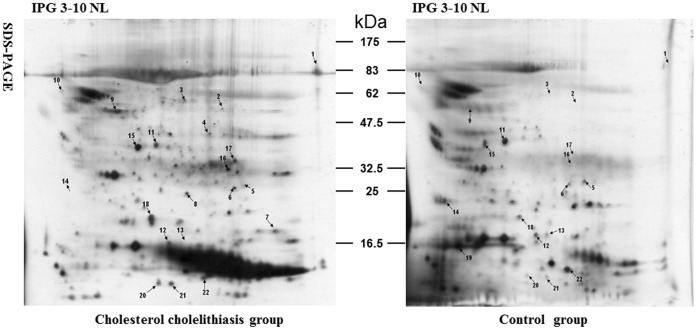
Representative 2-DE profiles of gallbladder bile proteins from cholesterol cholelithiasis group and control group.The proteins (250 µg) were subjected to 2-DE system (first dimension, IPG strip, pH 3–10 NL, 13 cm; second dimension, 12% SDS-PAGE). Protein spots were visualized by silver staining and analyzed by ImageMaster™ 2-D Platinum software. The spots marked with arrows indicate the distribution of up-regulated or down-regulated proteins that were successfully identified by MALDI-TOF. The numbers between the two images show the molecular marker (kDa). Annotations in the gels refer to the Spot No. are in Table 2.